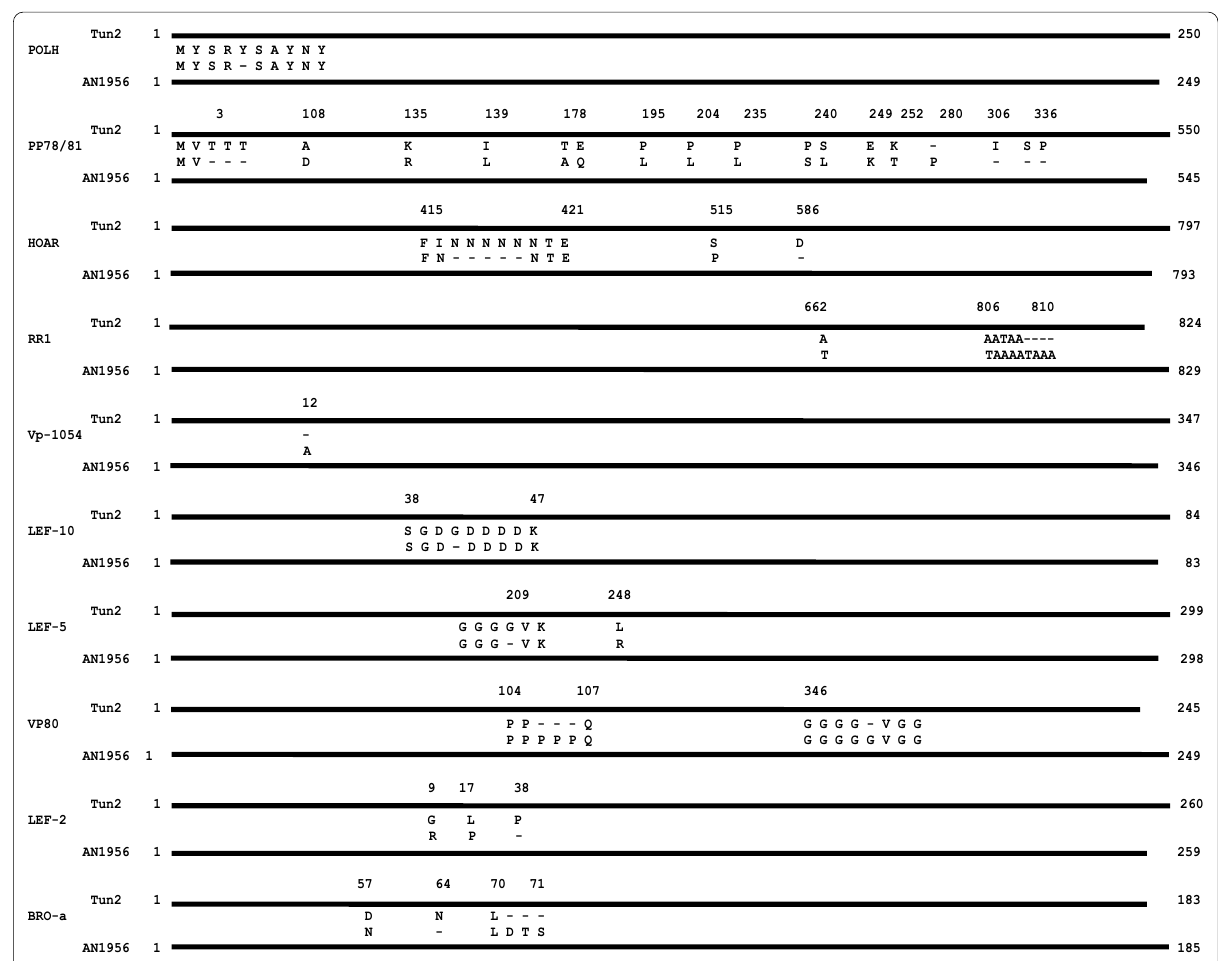
Fig. 4 Graphic representation of selected open reading frames with insertion and deletion (indel) mutations and amino acid changes of SpliNPV-Tun2 and -AN1956 (JX454574). The total protein length of each open reading frame (ORF) is shown to the right, while the numbers above each insertion/deletion region represent the corresponding amino acids from the aligned reference sequence. Deletions/insertions/substitution are illustrated between the bars